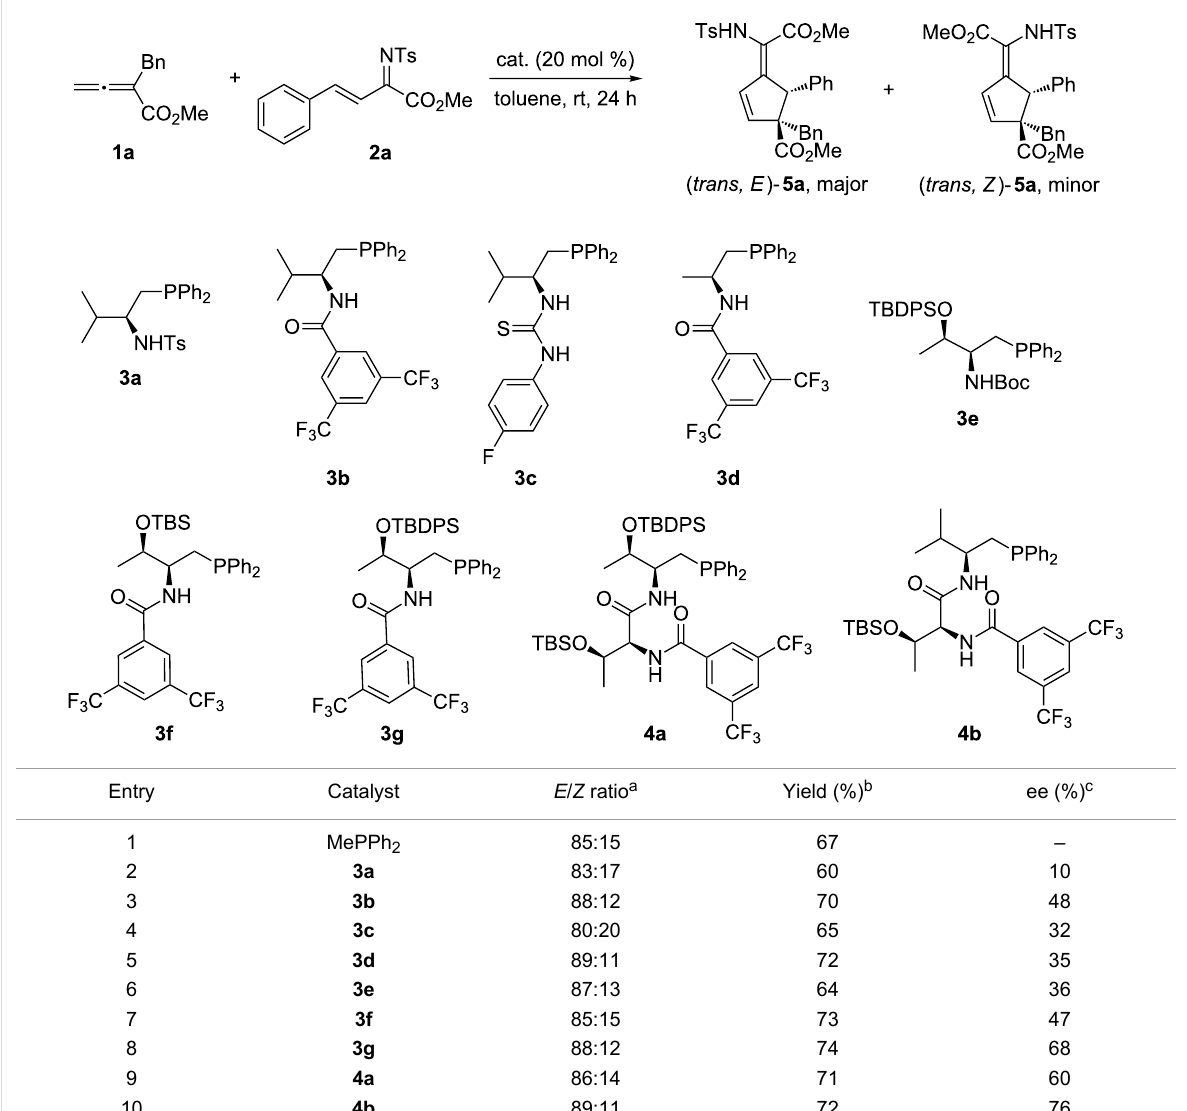
Table 1: Screening of different amino acid-based bifunctional phosphine